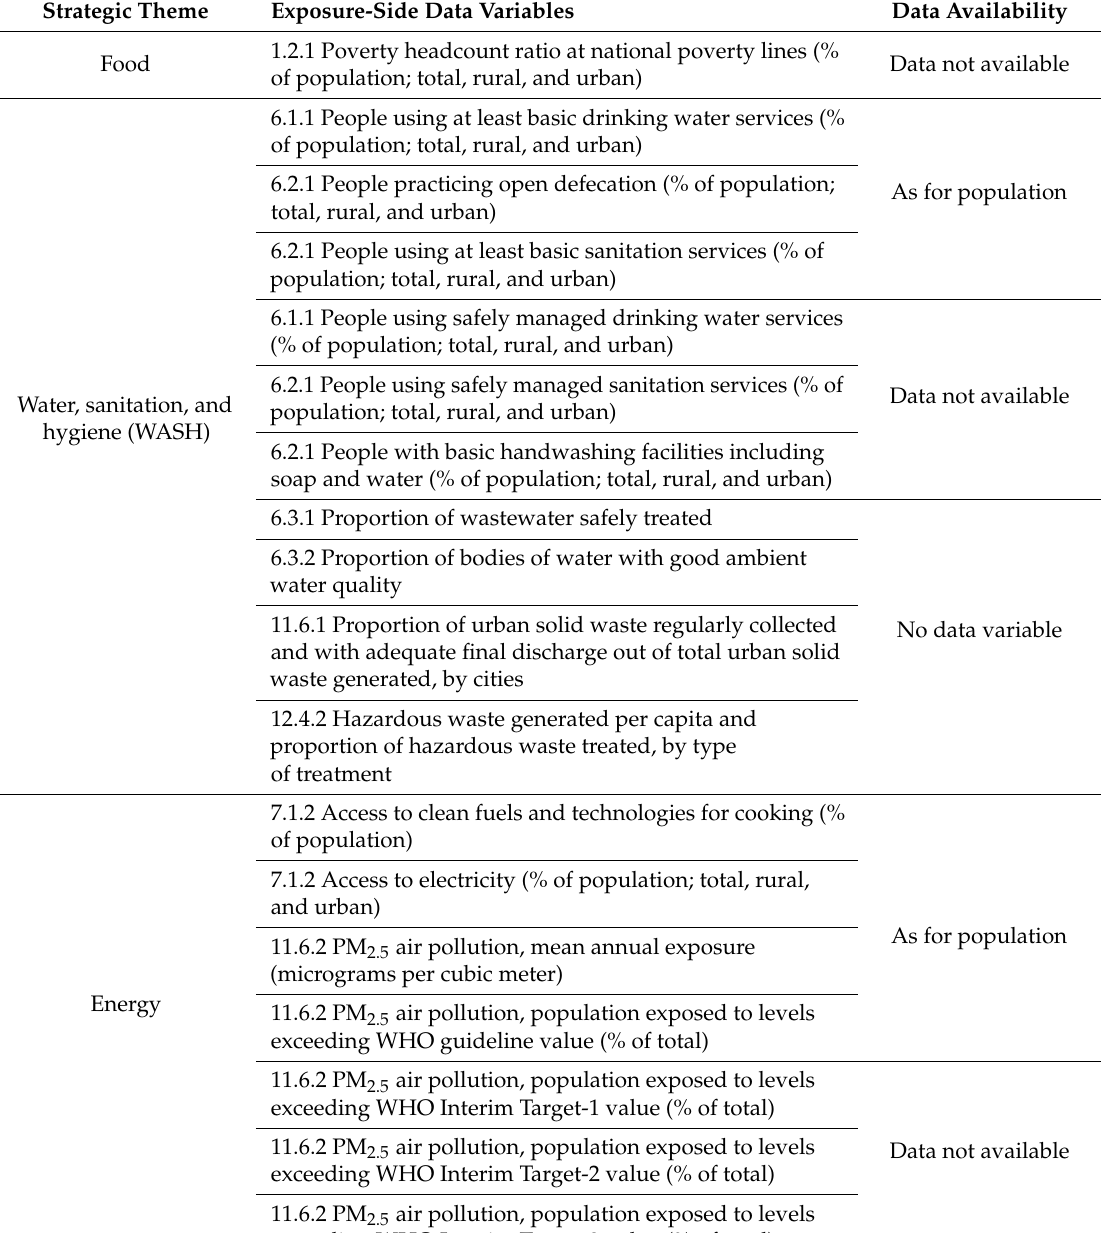
Table 2. Data on the selected exposures in Pacific Island small states